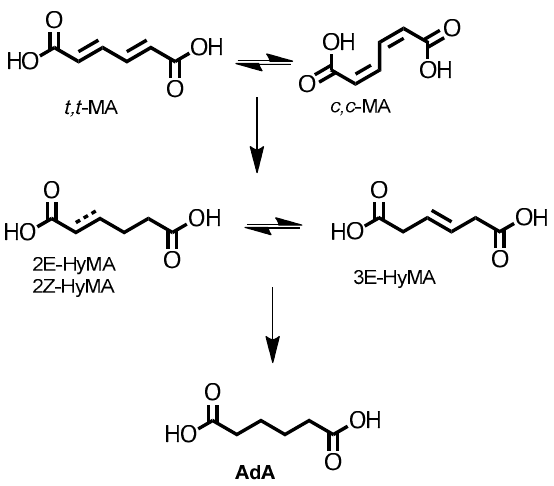
Figure 6. Scheme of MA conversion to AdA.